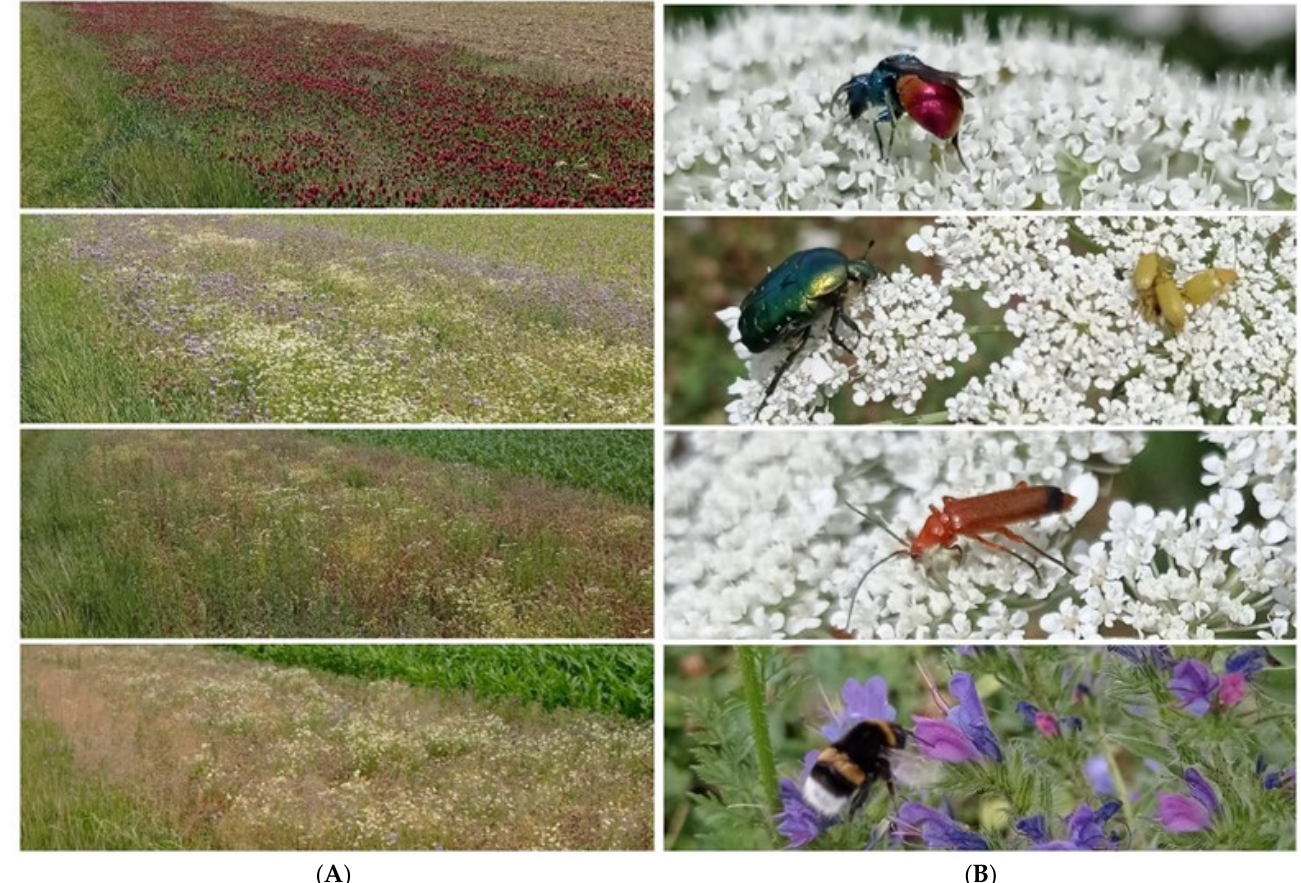
Figure 2. Differentiation of blooming plants and insects in a flower strip in the National Park of Greater Poland: ( A ) blooming plants of the flower strip from the beginning of May to the end of June, every two weeks. ( B ) Diversity of insects in the flower strips; species from the top: Chrisis ignita L.—parasitic wasp, Protaoetia cuprea metallica Herbst, Rhagonycha fulva Scopoli—predatory beetles, Bombus lucorum L.—pollinator (authors’ observations, 2022).